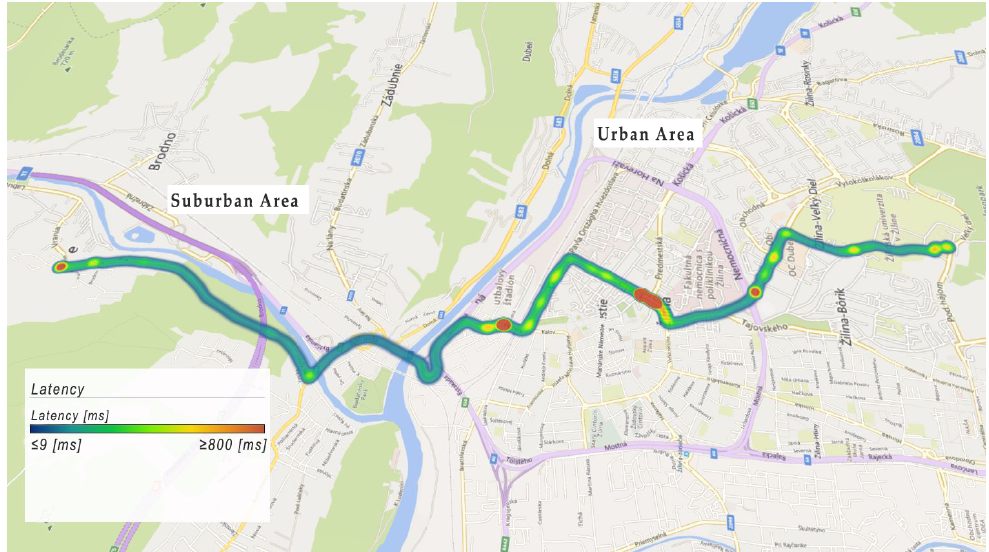
Figure 12. Example of latency data